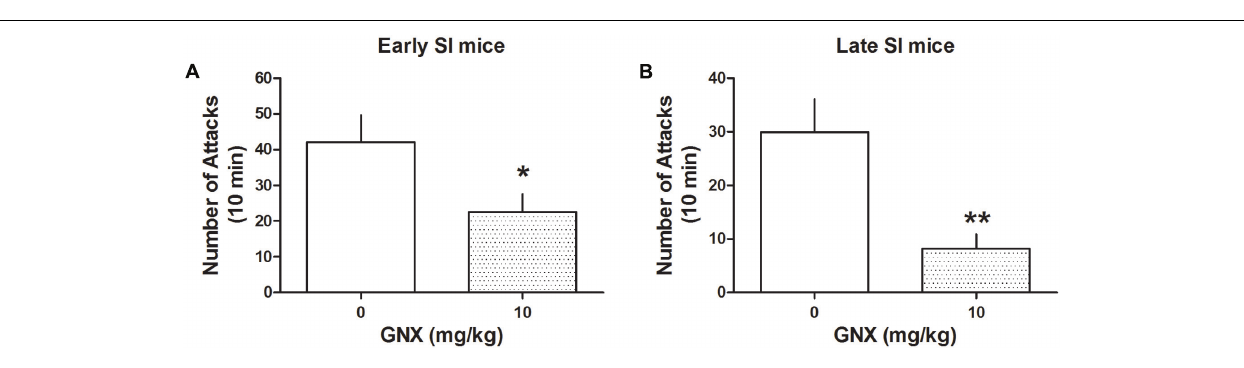
2.5 mg/kg [day 1: t (53) = 2.518, p = 0.0149; day 3: t (53) = 2.386, p = 0.0206; day 5: t (53) = 3.159, p =